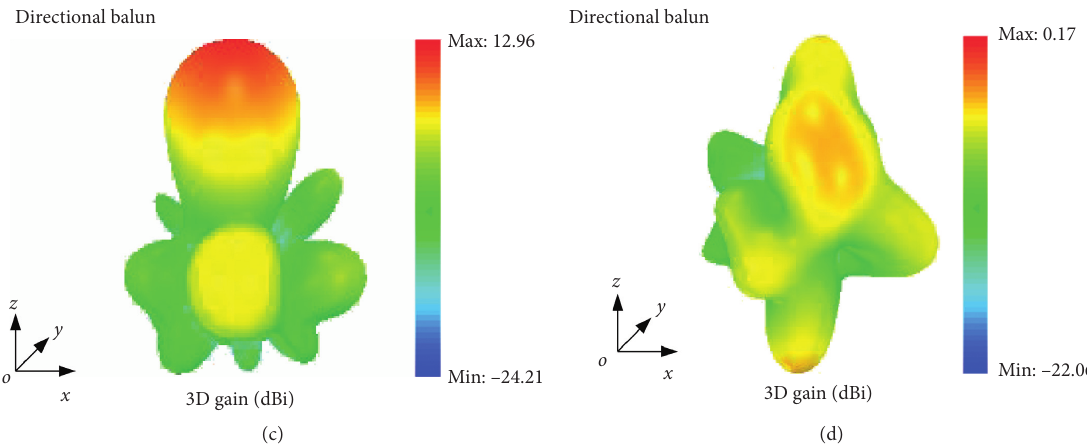
Figure 11: Comparison of 3D gain (0.2 λ e ). (a) Array with SRRs. (b) Array without SRRs. (c) Array with SRRs. (d) Array without SRRs.